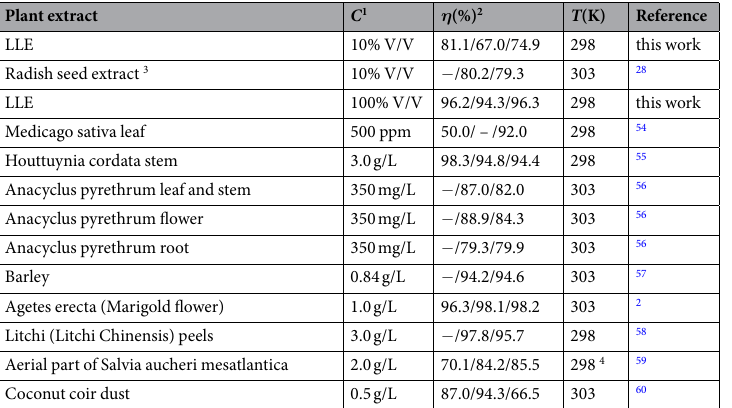
Table 4. The inhibition efficiency of LLE on the corrosion of steel in 0.5 M H 2 SO 4 solution compared with that of other extract described in literature. NOTE: 1 Concentration corresponding to the maximum corrosion inhibition efficiency. 2 The inhibition efficiency was listed in the order as follows: weight loss, electrochemical impedance spectroscopy and potentiodynamic polarization. 1 The inhibition efficiency was tested in 1 M H 2 SO 4 solution. 4 The temperature of weight loss method is 303